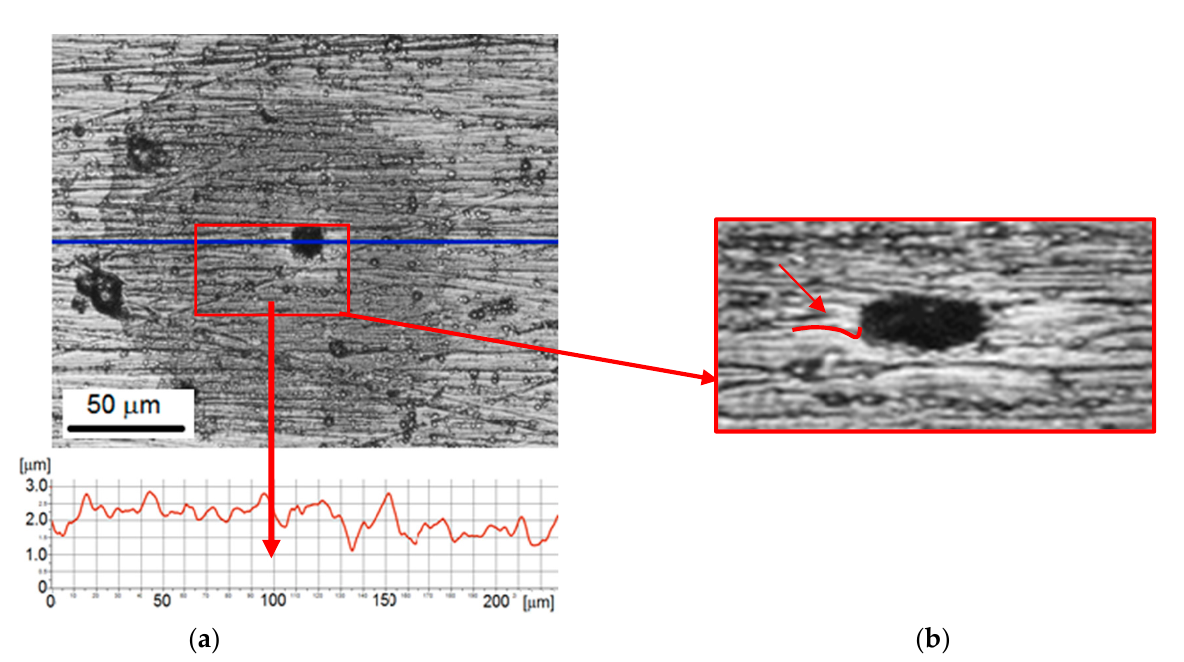
Figure 7. Nickel coating after 10 min of the cavitation erosion tests: ( a ) surface morphology with roughness profile along the selected measurement line; ( b ) 3D surface profile.